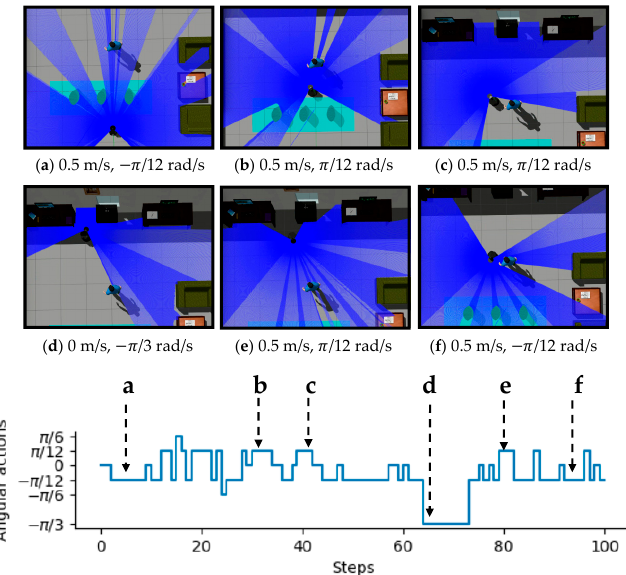
Editable version Figure 7. An example of dealing with different kinds of obstacles in virtual testing environment. The subfigures show the top view of six intermediate time steps and the sub-captions indicate the corresponding linear and angular velocity commands. Angular velocity commands in all time steps are provided at the bottom.